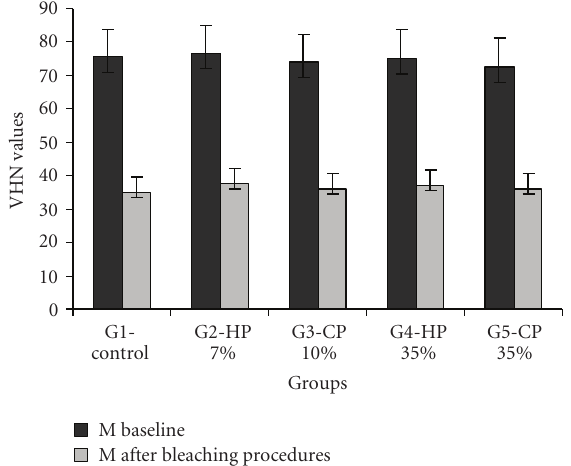
Figure 2: Microhardness mean values (M) and standard deviation (SD) for all Groups baseline and after bleaching procedures (G1: control; G2: Hydrogen peroxide 7%; G3: Hydrogen peroxide 35%; G4: Carbamide peroxide 10%; G5: Carbamide peroxide